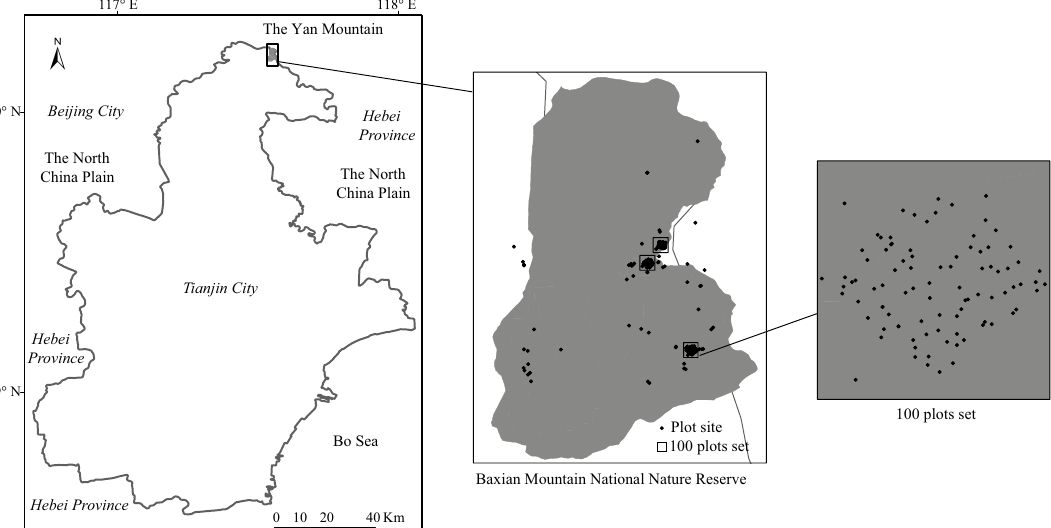
Figure 1. Baxian Mountain National Nature Reserve and plot sites. Three black square boxes in the second map show the location of three plot sets, and each of them has one hundred 10 m × 10 m plots. The red dots in the 100-plot set are plots we sampled and picked. This figure was generated in R language (version